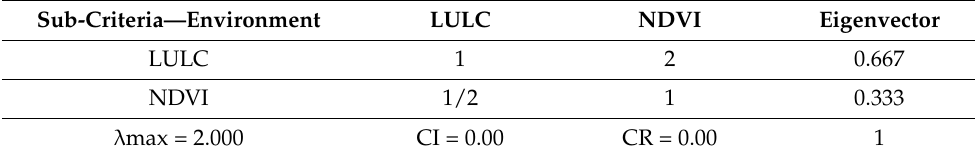
Table 7. Pair-wise comparison matrix of sub-criteria for environment.